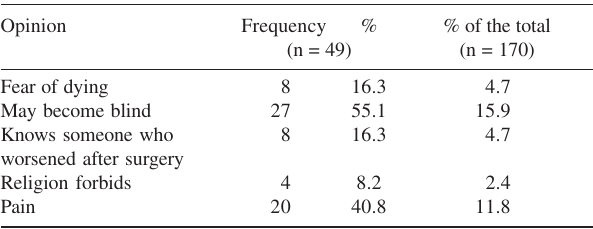
Table 6 - Reasons for the fear of surgery (Affirmative